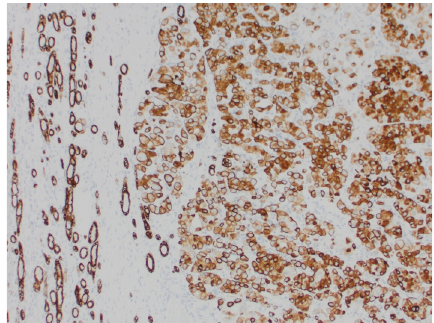
Figure 6: Microscopic (40x) renal tumor cells demonstrated posi- tive staining for CK7.